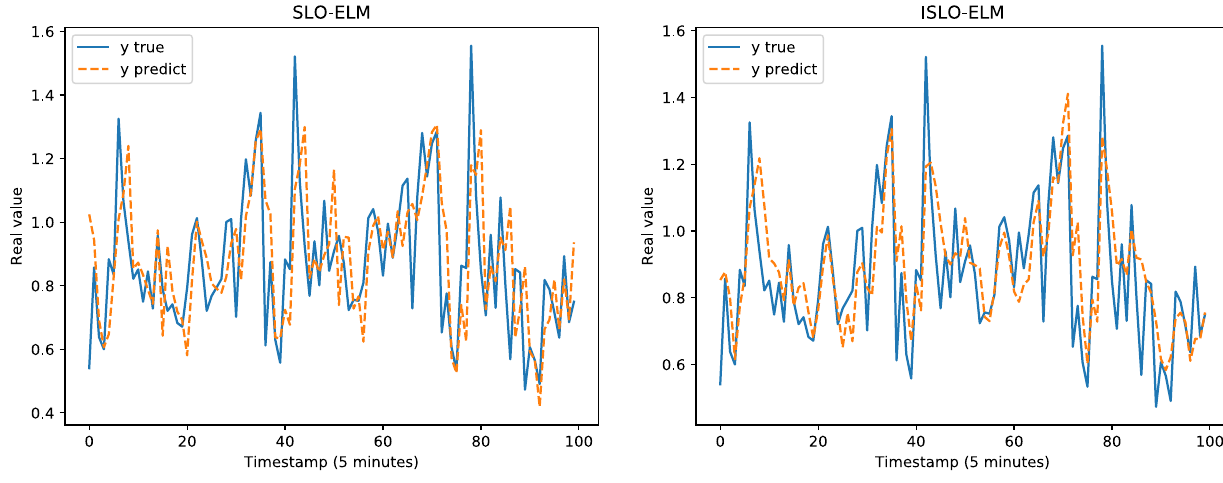
Fig. 8 Prediction results of SLO-ELM and our ISLO-ELM on Google trace CPU